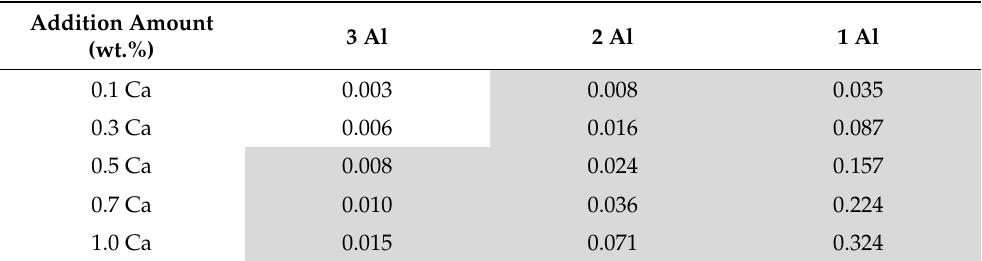
Table 2. Thermodynamic calculation results of the Ca concentration in matrix at 420 °C under an equilibrium condition, using the FactSage software. Gray shaded area indicates the alloys with the TD-split texture component.